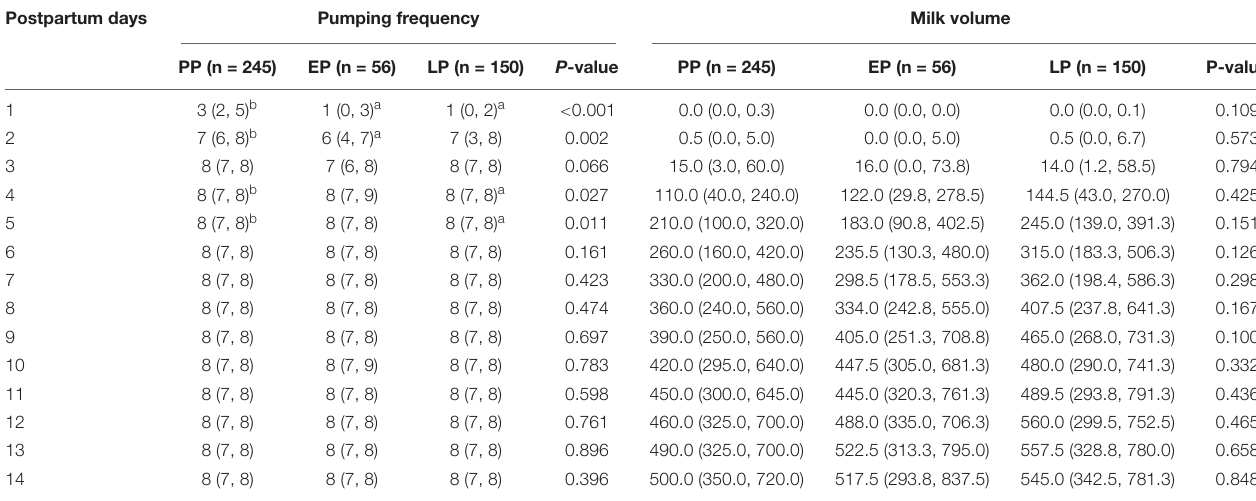
TABLE 3 | Daily milk pumping frequency and milk volume on day 1–14 postpartum.